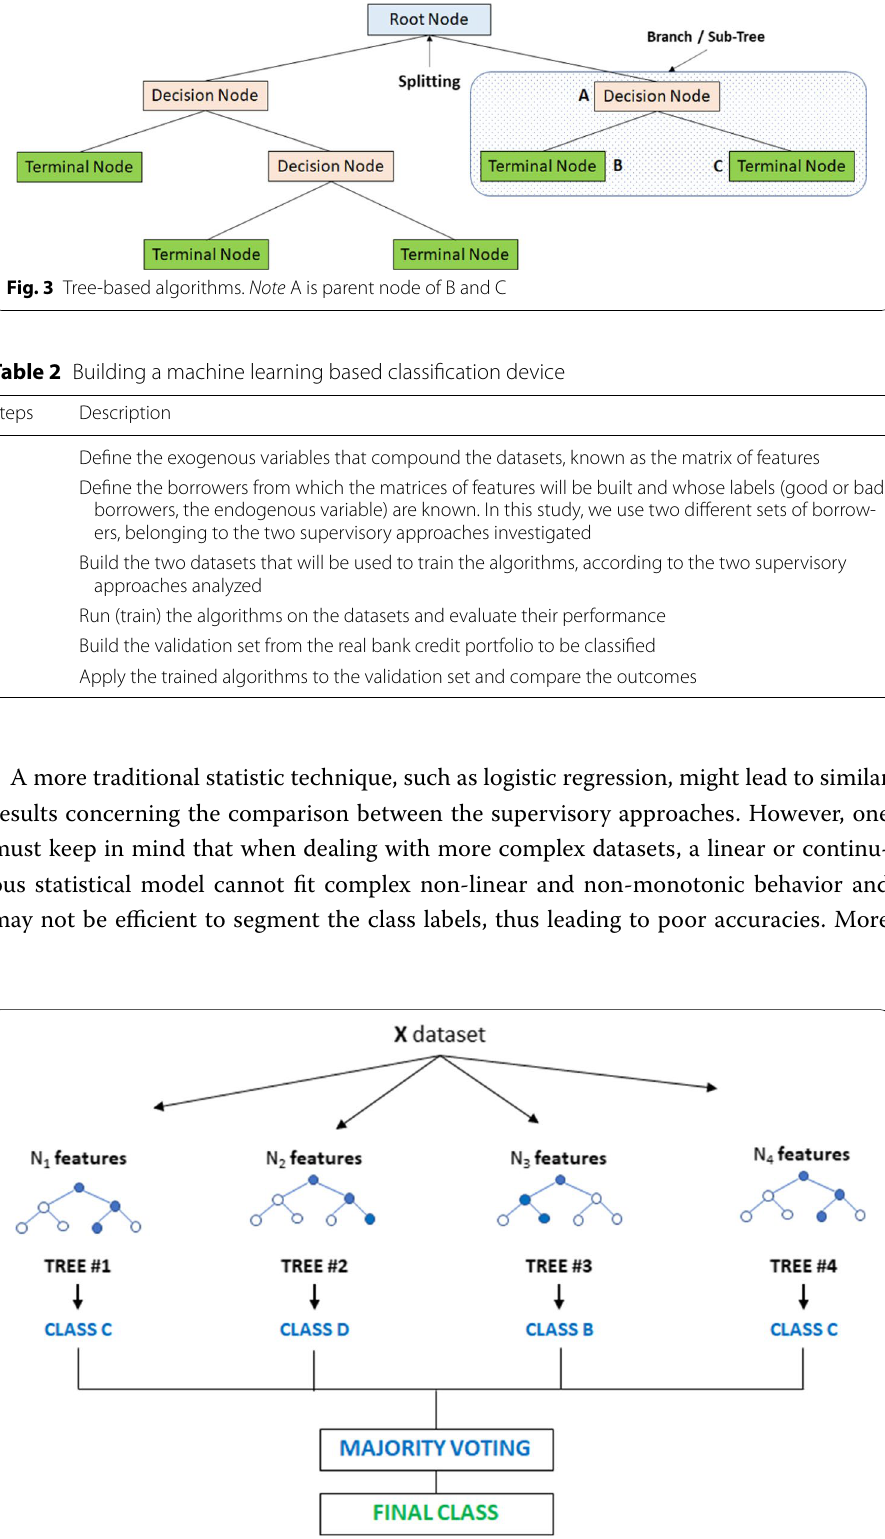
Fig. 4 Example of random forest decision